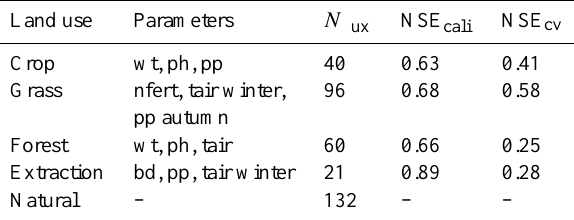
Table 3. List of calibrated and validated N 2 O fuzzy logic models with covariates that are described in Table 1 (Parameters), number of flux measurements (N flux ) and model performances of calibra- tion (NSE cali ) and cross validation (NSE cv ) for different land use categories, respectively.